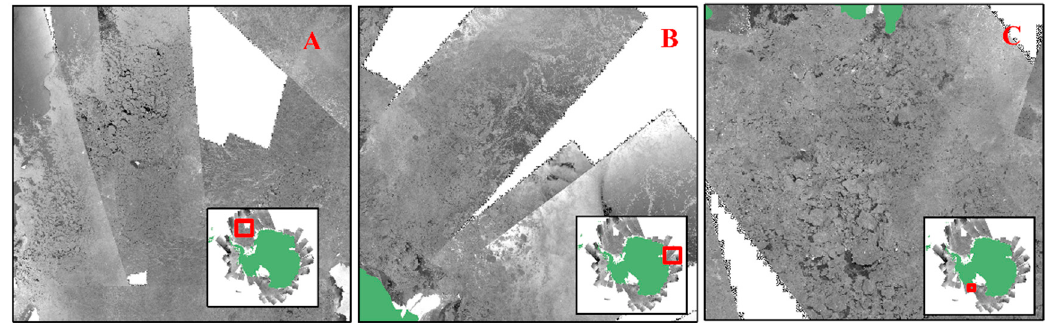
Figure 20. Sea ice floes of the Antarctic region on 15 November 2018: Figure 20A is the Weddell Sea; Figure 20B is the Pulitzer sea; and Figure 20C is the Ross Sea.